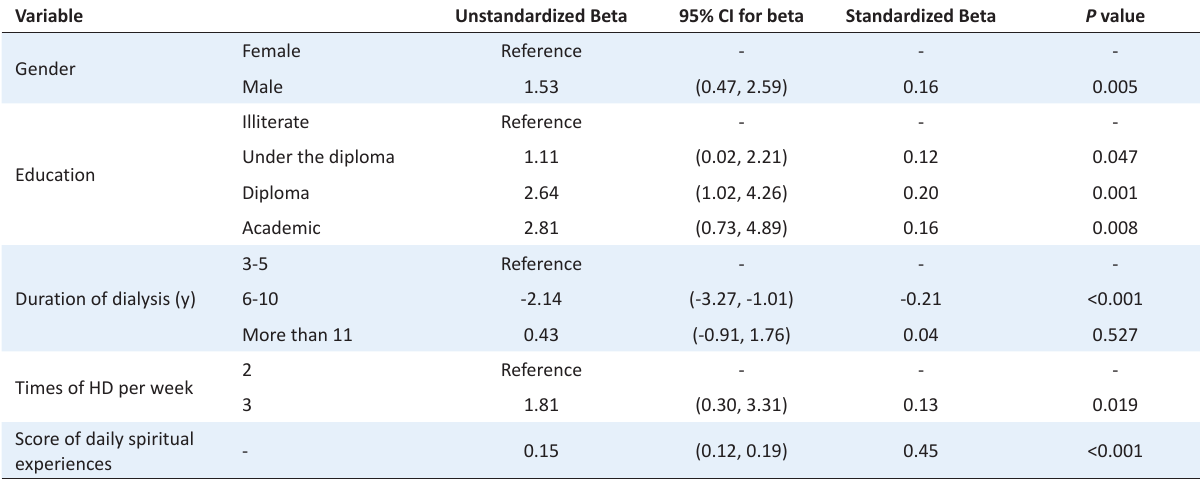
Table 3. Multiple linear regression of the predictors of the level of hope in patients undergoing hemodialysis in Qazvin, Iran